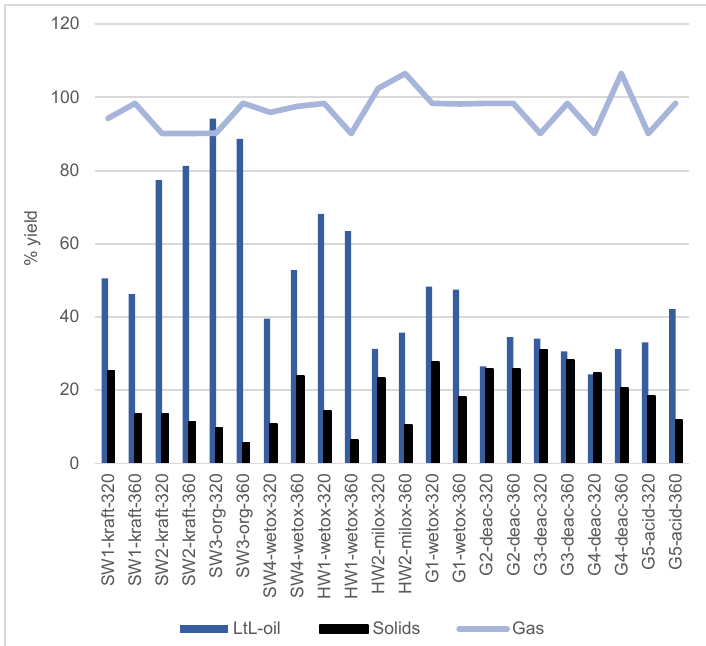
Figure 10. LtL-oil yield and solid yield presented as the weight percent of lignin input. SW3 experiments are included for comparison. The gas yields are given as a continuous line. Gas yields larger than 100% imply a significant contribution of gas-phase products from lignin feedstock reactions. All results regarding SW3 have previously been published in Løhre et al. [36].